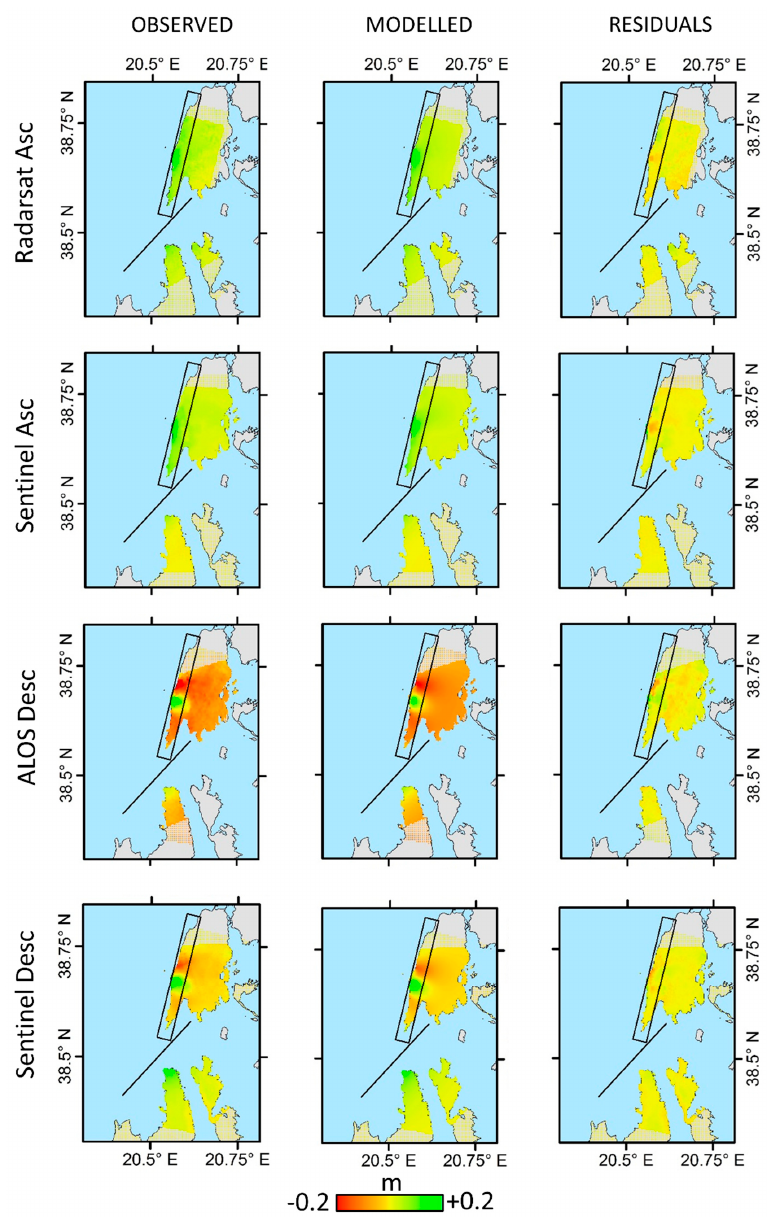
Figure 6. Observed, modelled, and residuals of the linear inversion.